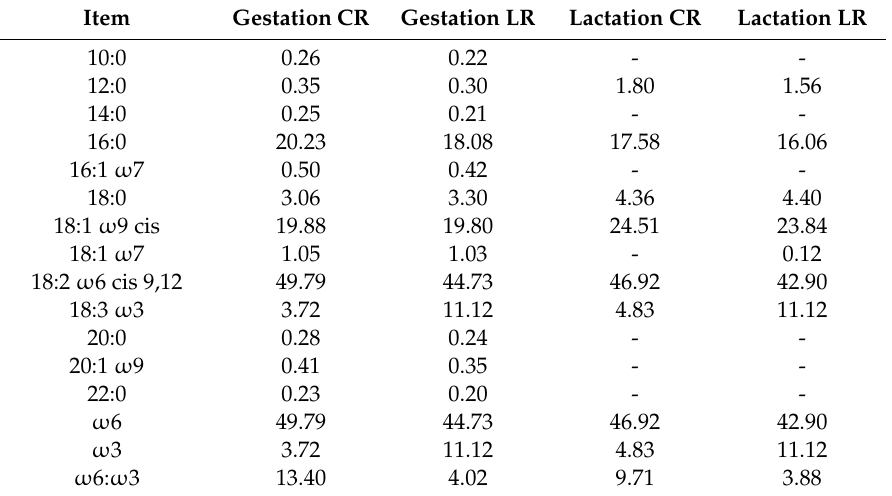
Table 2. Fatty Acid (g / 100 g total fatty acids) of sow